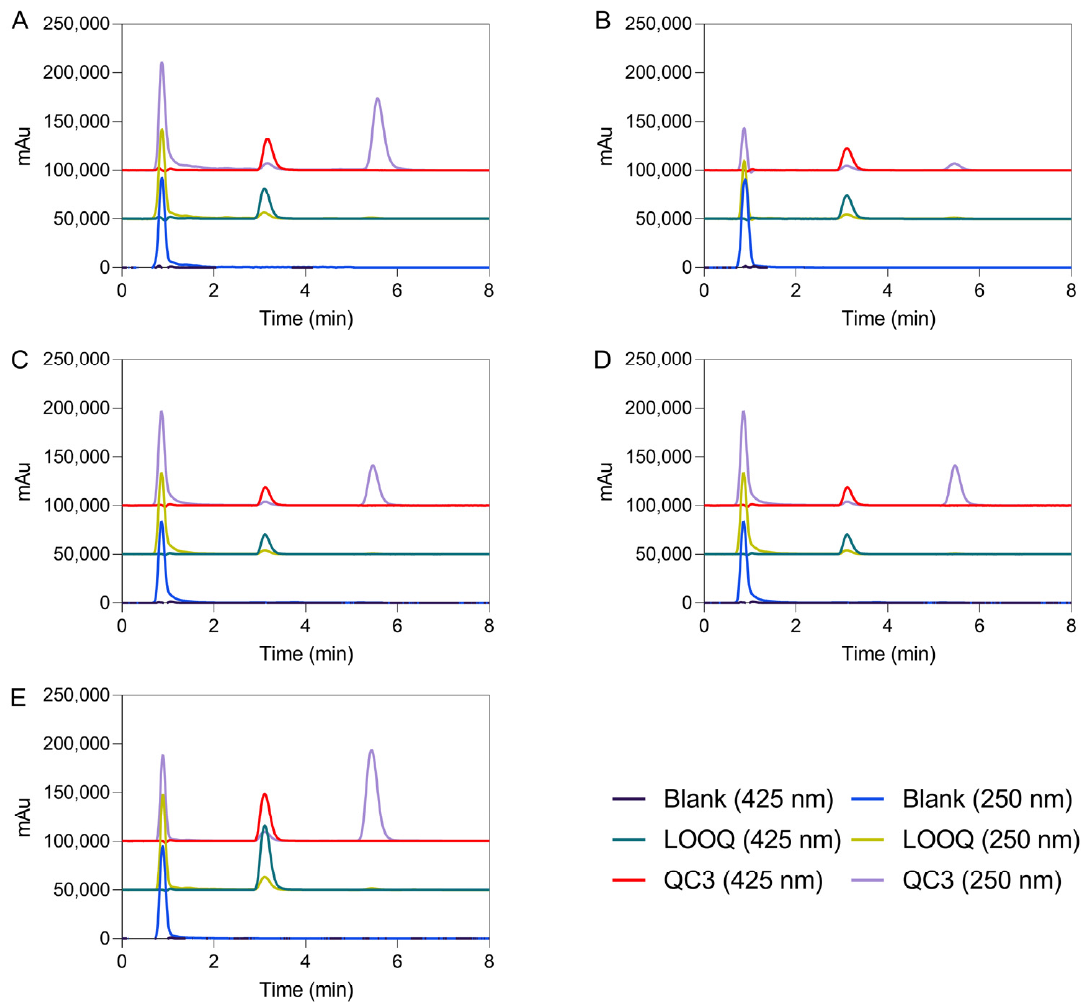
Figure 1. Representative HPLC chromatograms of IS (425 nm) and celecoxib (250 nm), in plasma ( A ), brain ( B ), spleen ( C ), liver ( D ), and kidney ( E ) homogenate supernatants, respectively, with LLOQ standing for the lower limit of quantification and QC 3 , the high-quality control of the corresponding calibration curves. Chromatograms of blank samples at 425 and 250 nm are also illustrated. IS and celecoxib were eluted at ~3.12 and 5.55 min,